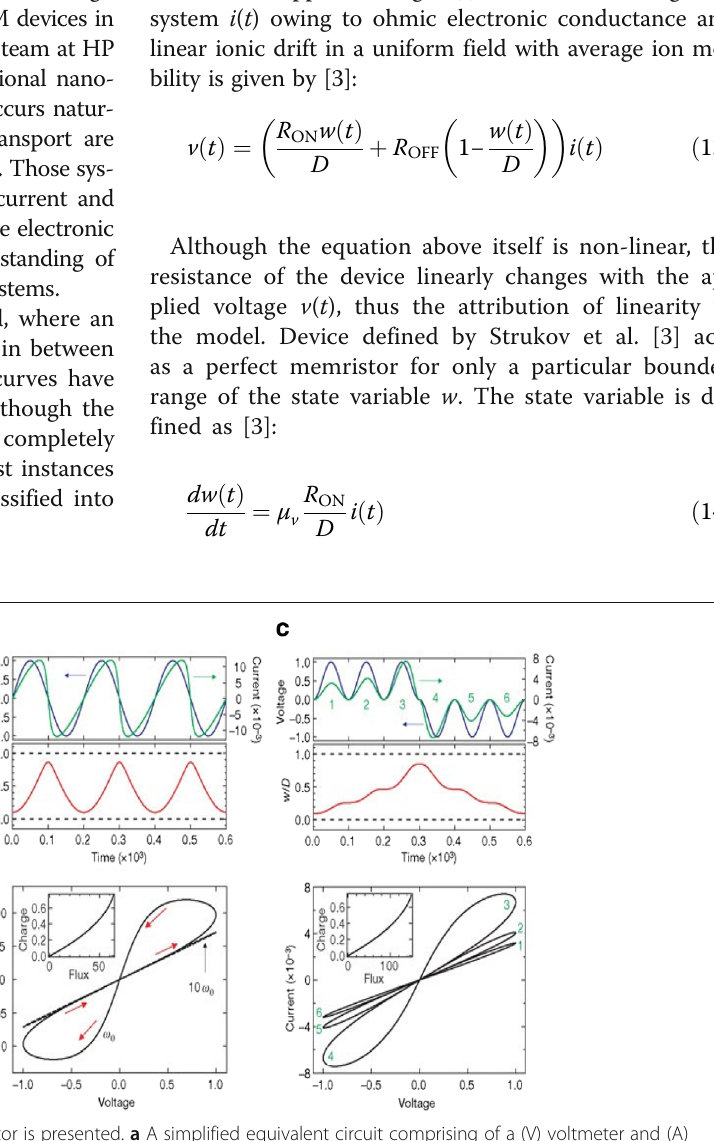
Fig. 2 The coupled variable-resistor model for a memristor is presented. a A simplified equivalent circuit comprising of a (V) voltmeter and (A) ammeter. b , c The applied voltage (blue) and resulting current (green) as a function of time t for a typical memristor are also presented. In b the applied voltage is v 0 sin( v 0 t ) and the resistance ratio is R OFF / R ON = 160, and in c the applied voltage is ± v 0 sin 2 ( ω 0 t ) and R OFF / R ON = 380, where ω 0 is the frequency and v 0 is the magnitude of the applied voltage. The numbers 1 – 6 are labeled for successive waves in the applied voltage and the corresponding loops in i – v curves. In each plot, the axes are dimensionless, with voltage, current, time, flux, and charge expressed in units of v 0 = 1 V, i 0 ≡ v 0 / R ON = 10 mA, t 0 ≡ 2 π / ω 0 ≡ D 2 / μ v v 0 = 10 m/s, v 0 t 0 and i 0 t 0 , respectively. The term i 0 denotes the maximum possible current through the device, and t 0 is the shortest time required for linear drift of dopants across the full device length in a uniform field v 0 / D , for example with D = 10 nm and μ V = 10 − 10 cm 2 s − 1 V − 1 . It is to be noted that for the parameters chosen, the applied bias never forces either of the two resistive regions to collapse; for example, w / D does not approach zero or one (shown with dashed lines in the middle plots in b and c ). Also, the dashed i – v plot in b demonstrates the hysteresis collapse observed with a tenfold increase in sweep frequency. The insets of i – v plots in b and c show that for these examples, the charge is a single-valued function of the flux, as it must be in a memristor